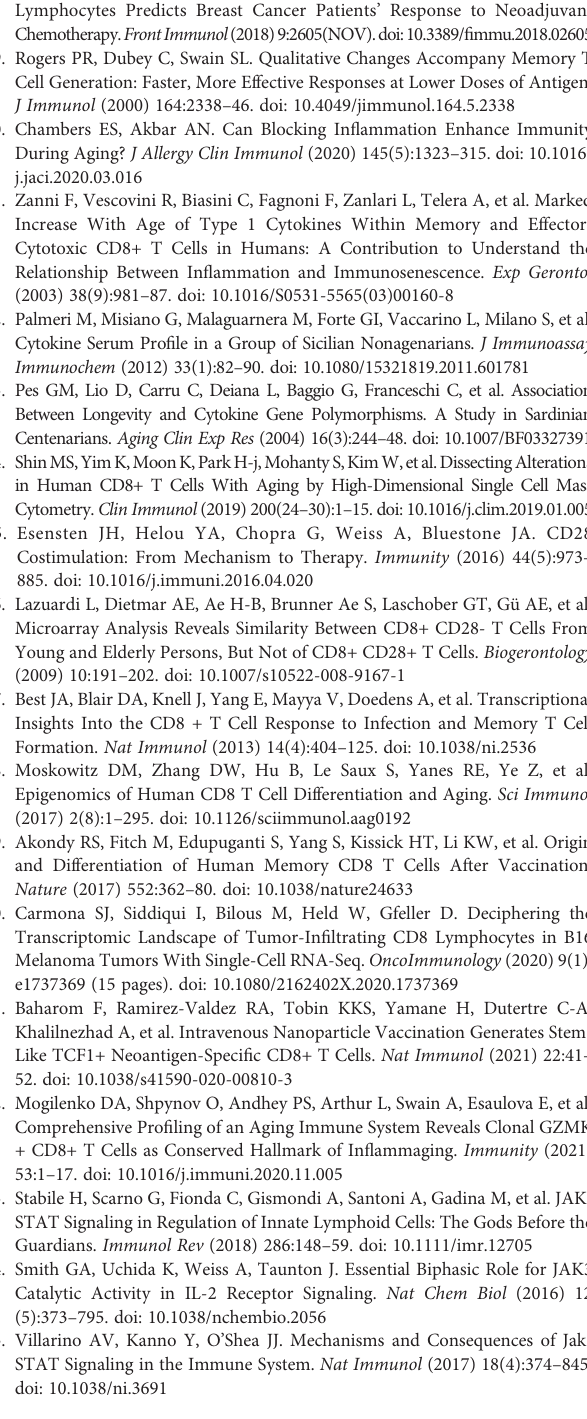
blue squares, old female donors dark red squares, and old male donors dark blue squares. (B) . PCA for the CD8 + CD45RA - memory T cell subpopulation. The young female donors are light red hollow circles, young male donors light blue hollow circles, old female donors dark red hollow circles and old male donors dark blue hollow